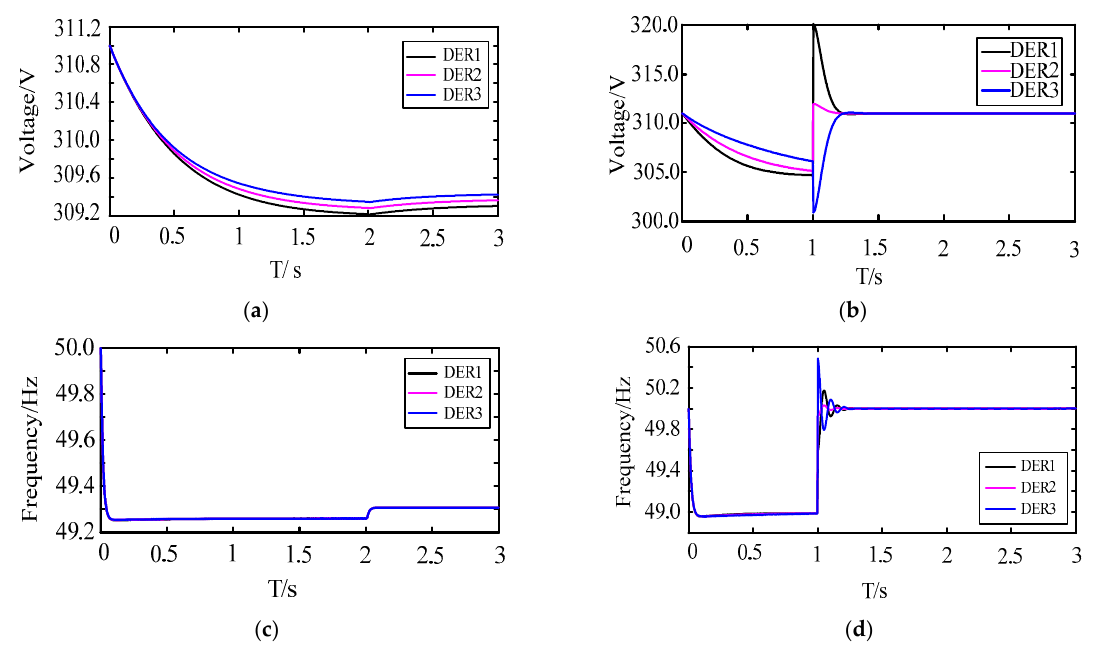
Figure 7. Variations of DERs when Load2 is cut down at t = 2 s. ( a ) Variations of voltage by using traditional droop control; ( b ) Variations of voltage by using the novel distributed control; ( c ) Variations of frequency by using traditional droop control; ( d ) Variations of frequency by using the novel distributed control.